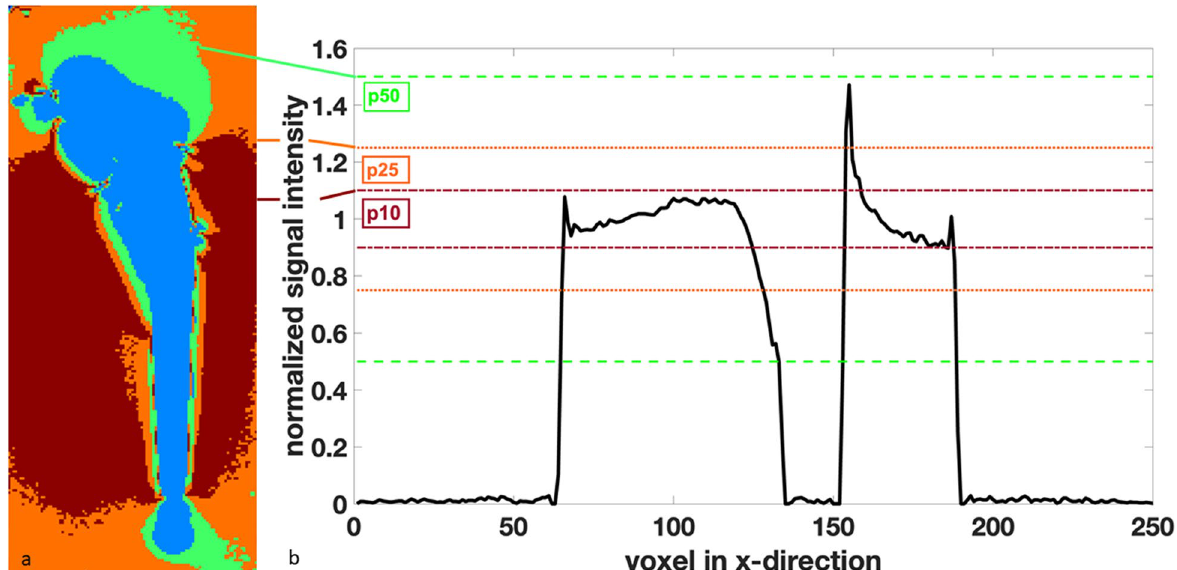
Fig. 3 Scheme of the fractions of voxel within a 10%, 25%, and 50% limit above or below the mean signal intensity ( a ). Corresponding signal curve along the x ‑axis at the middle of the shaft with visualization of the fractions p10, p25, and p50 ( b ). See text (in the “Methods” section) for explanation